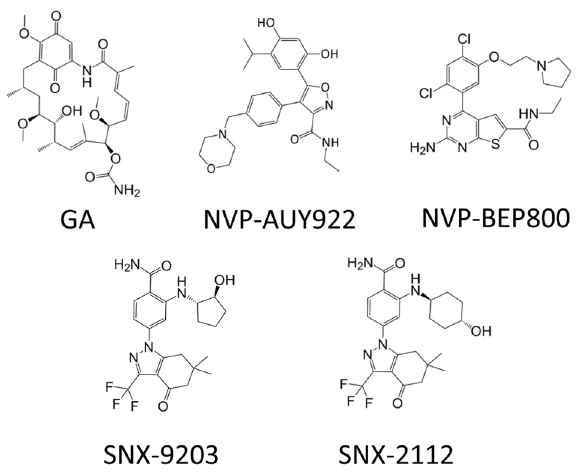
Figure 1. Structures of Hsp90 inhibitors used in the invitro experiments. Figure shows chemical structures of Geldanamycin (GA),